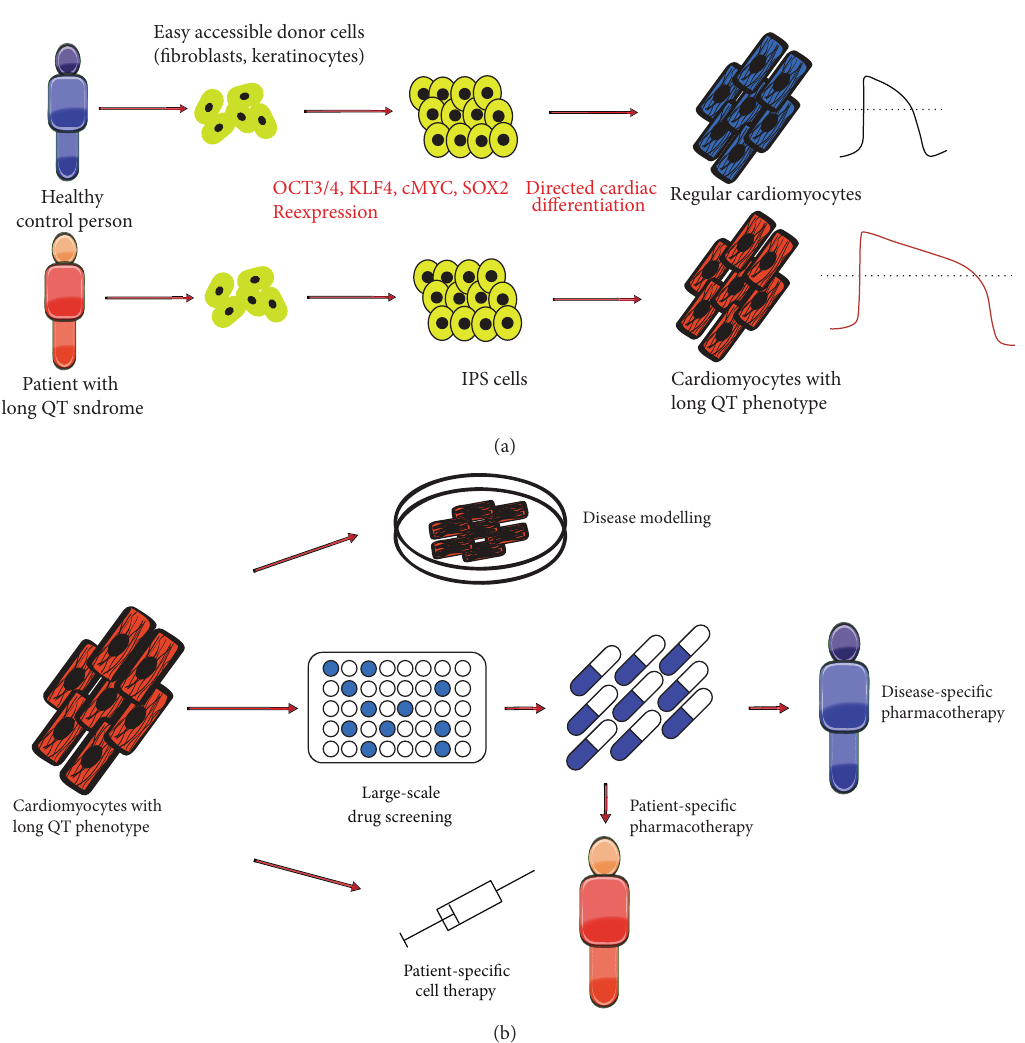
Figure 2: (a) Schematic presentation of iPSC-derived cardiomyocytes’ retrieval. Based on easy accessible donor cells, like, for example, fibroblasts and consequent overexpression of different pluripotency factors, reprogrammed donor cells fall into a state of pluripotency (iPS- Cells). By various forms of directed cardiac differentiation, cardiomyocyte-like cells show essential characteristics of adult cardiomyocytes, maintaining their LQT-/non-LQT-phenotype. (b) Possible applications for iPSC-derived cardiomyocytes: (i) disease modelling for better understanding of genetic and epigenetic causation of LQTS; (ii) large-scale drug screening for both patient-specific and nonspecific pharmacotherapy; (iii) circumventing transplantation-associated immunogenicity by patient-specific cell